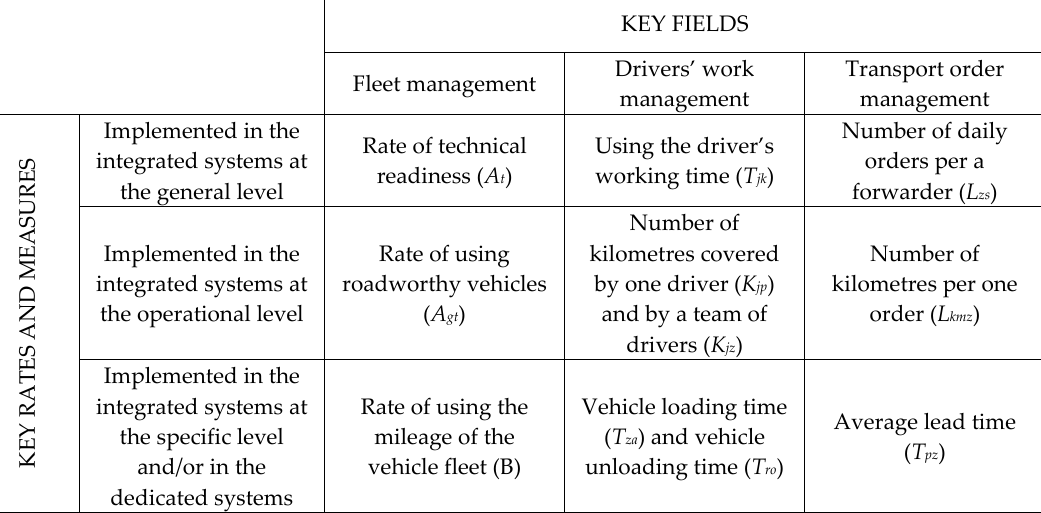
Figure 3. Matrix of rates indicating the organisational efficiency of the operational activities undertaken by road transport enterprises (RTEs), as determined by the implementation of IT systems.